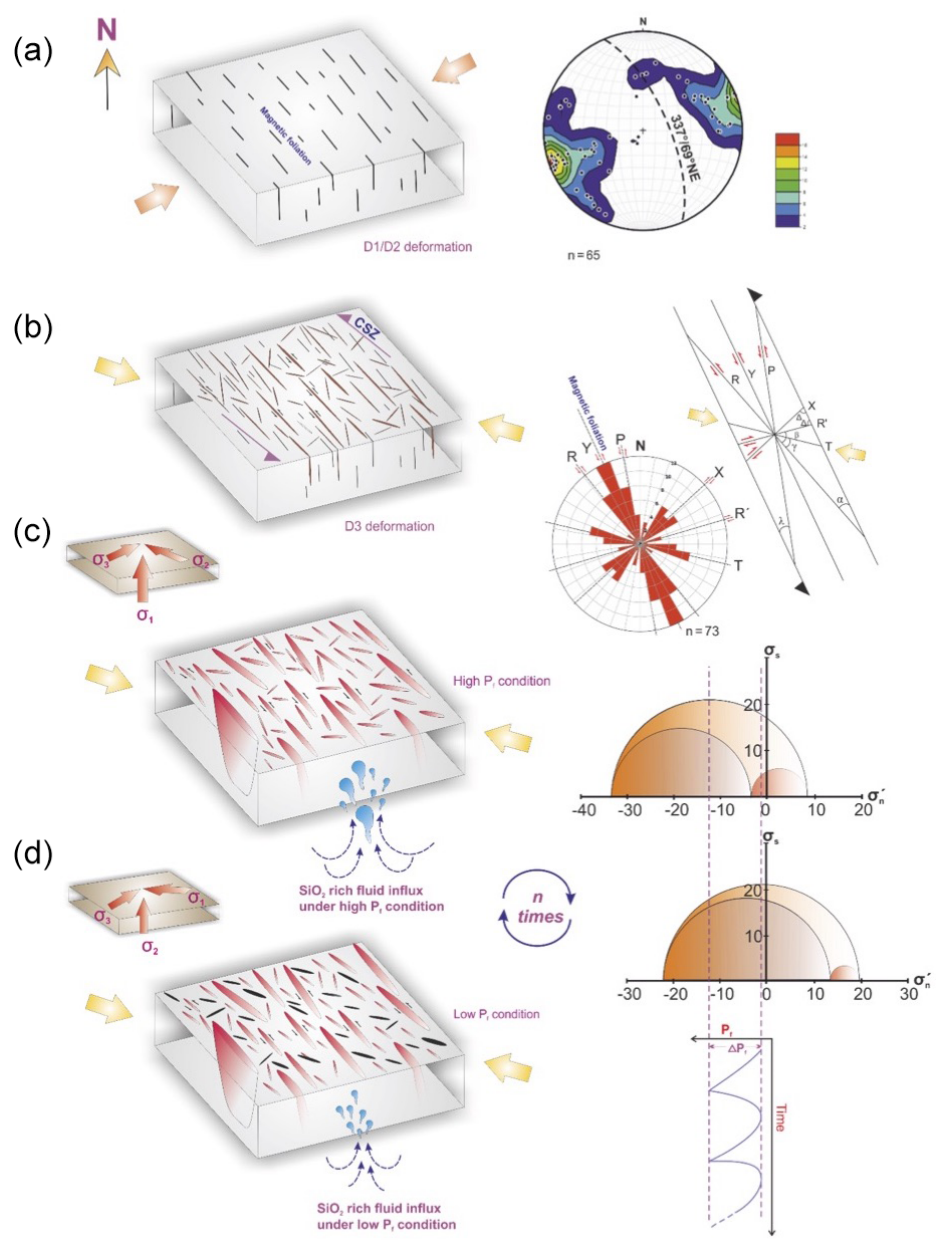
Figure 11. Schematic model showing formation and reactivation of fractures, along with vein emplacement in the metabasalt host rock. (a) Development of the NNW–SSE to NW–SE oriented magnetic fabrics in the rock unit under a NE–SW shortening related to D1/D2 deformation. Lower hemisphere equal area projection shows mean orientation of the magnetic fabric ∼ 337/69 ◦ NE. n : number of data. (b) Formation of the Y , P , R , R (cid:48) , X and T shears related to the riedel shear system under a NW–SE to E–W shortening related to the late D3 deformation (half arrows representing the shear zone boundary). The angles ( α , β , γ , λ and (cid:49) ) between the shear components are given following Logan et al. (1992). (cid:56) = 30 ◦ (angle of internal friction) is measured from UCS studies of the samples from the study area. Corresponding riedel shear model, with CSZ as the shear boundary and a rose diagram showing orientations of the respective shear components. n : number of data. (c) and (d) showing vein emplacement under high- P f and low- P f conditions, respectively (states of stresses along the fracture planes are given in (c) ; σ 1 is vertical due to fluid overpressure). Corresponding 3-D Mohr circle diagrams quantifying the effective normal stresses ( σ (cid:48) n = σ n − P f are given in MPa) under both high- and low- P f conditions, P f variation ( (cid:49)P f ∼ 11 . 25MPa), obtained from the dashed lines representing the mean stress in each case. A conceptual graph shows multiple cycles ( n times) of high- and low- P f conditions in the study area justifying fault-valve action that led to the emplacement of veins in the Chitradurga